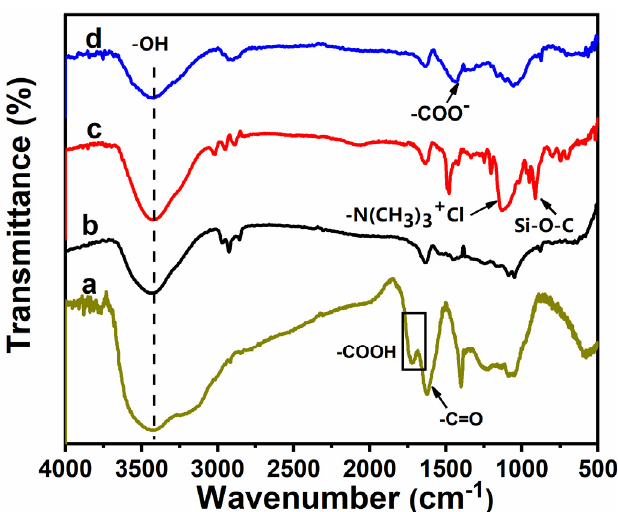
Figure 3. FTIR spectra of carbon fiber: ( a ) GO, ( b ) Untreated CF, ( c ) CF-KHN + , ( d ) CF-KHN + -4GO.